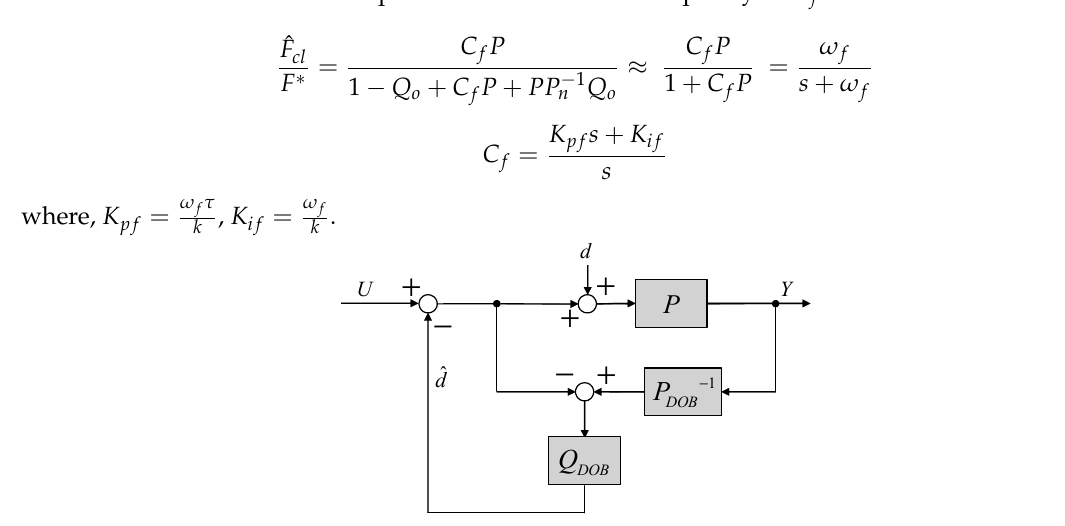
8 of 13 Figure 9. Frequency response function for the closed-loop transfer function with a notch filter: ( a ) Magnitude plot; ( b ) Phase plot.